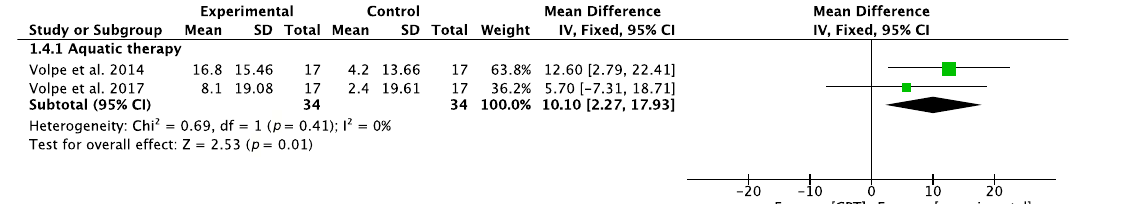
15 of 20 Figure 4. Forest plot for balance measured by BBS. Green block indicates the weight assigned to the study and the horizontal line depicts the confidence interval. Black rhombus shows the overall result. The bold words highlight the total/subtotal values and the different modalities of therapies used in the interventions.